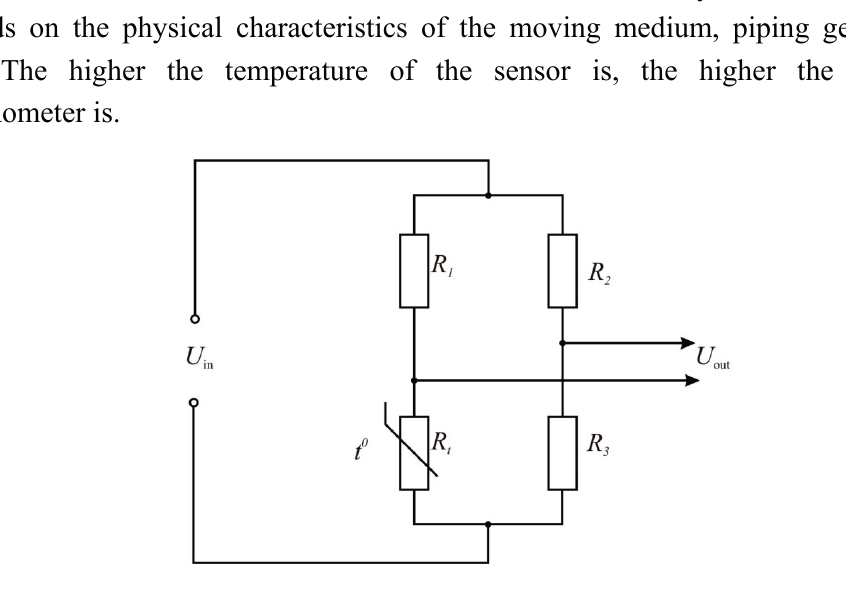
Figure 1. Measuring bridge of a thermo-anemometer ( t 0 —the measured